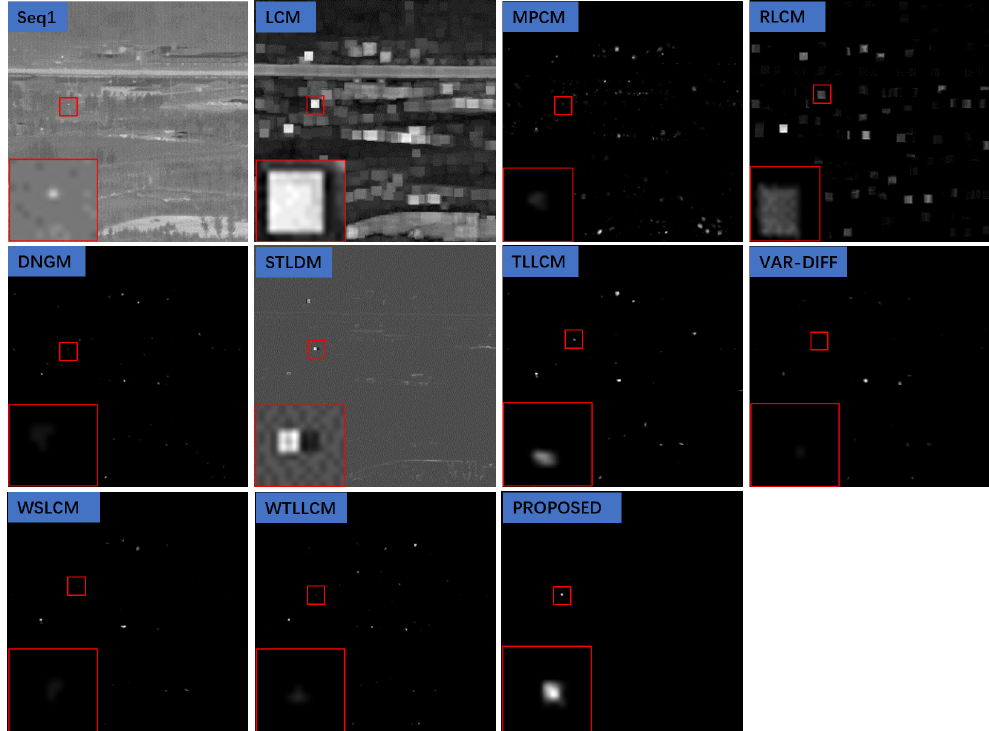
Figure 15. Detection results of one frame in data1. The first sub-image is the original image, and the rest are the detection results of each algorithm.